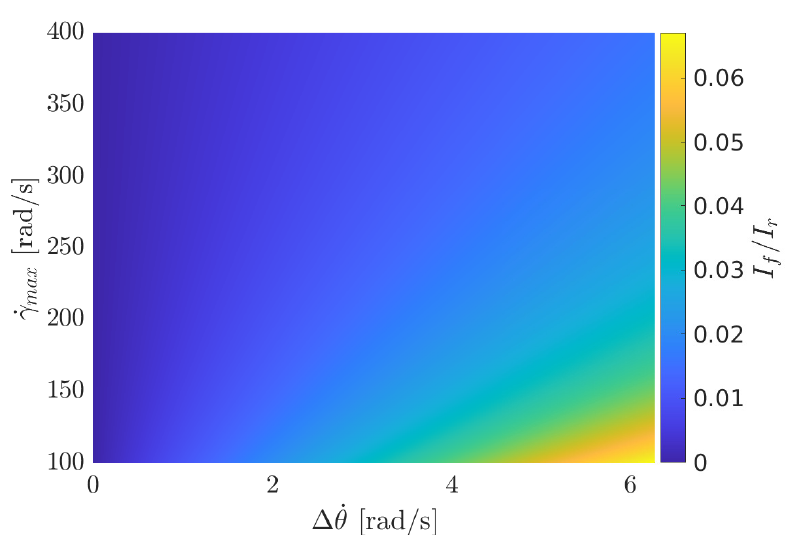
Figure 3. Minimum inertia of the OCS (normalized by the robot’s inertia) necessary to achieve a base velocity variation ∆ ˙ θ , given the actuation bound ˙ γ max